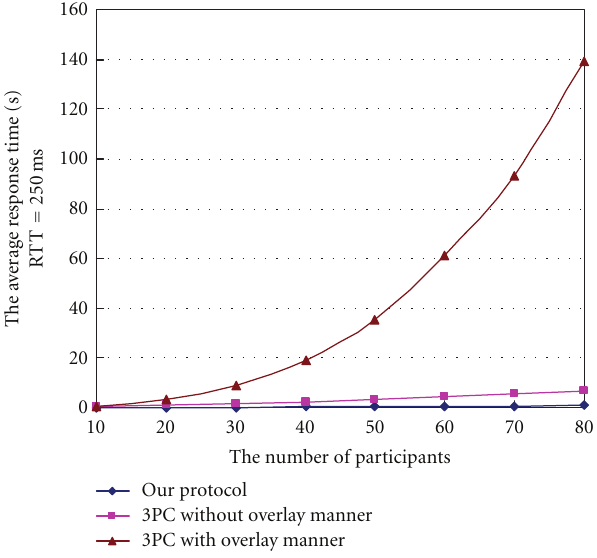
Figure 6: The average CPU time for each